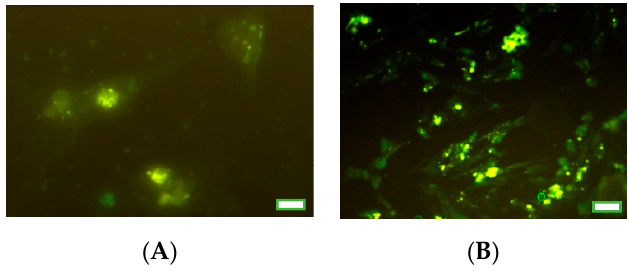
Figure 1. Fluorescence microscopy images of porcine granulosa cells containing fluorescein isothiocyanate (FITC, green fluorescence), indicating the proliferating cell nuclear antigen (PCNA; A ) or Bcl-2-associated X protein (bax; B ). Scale bars represent 10